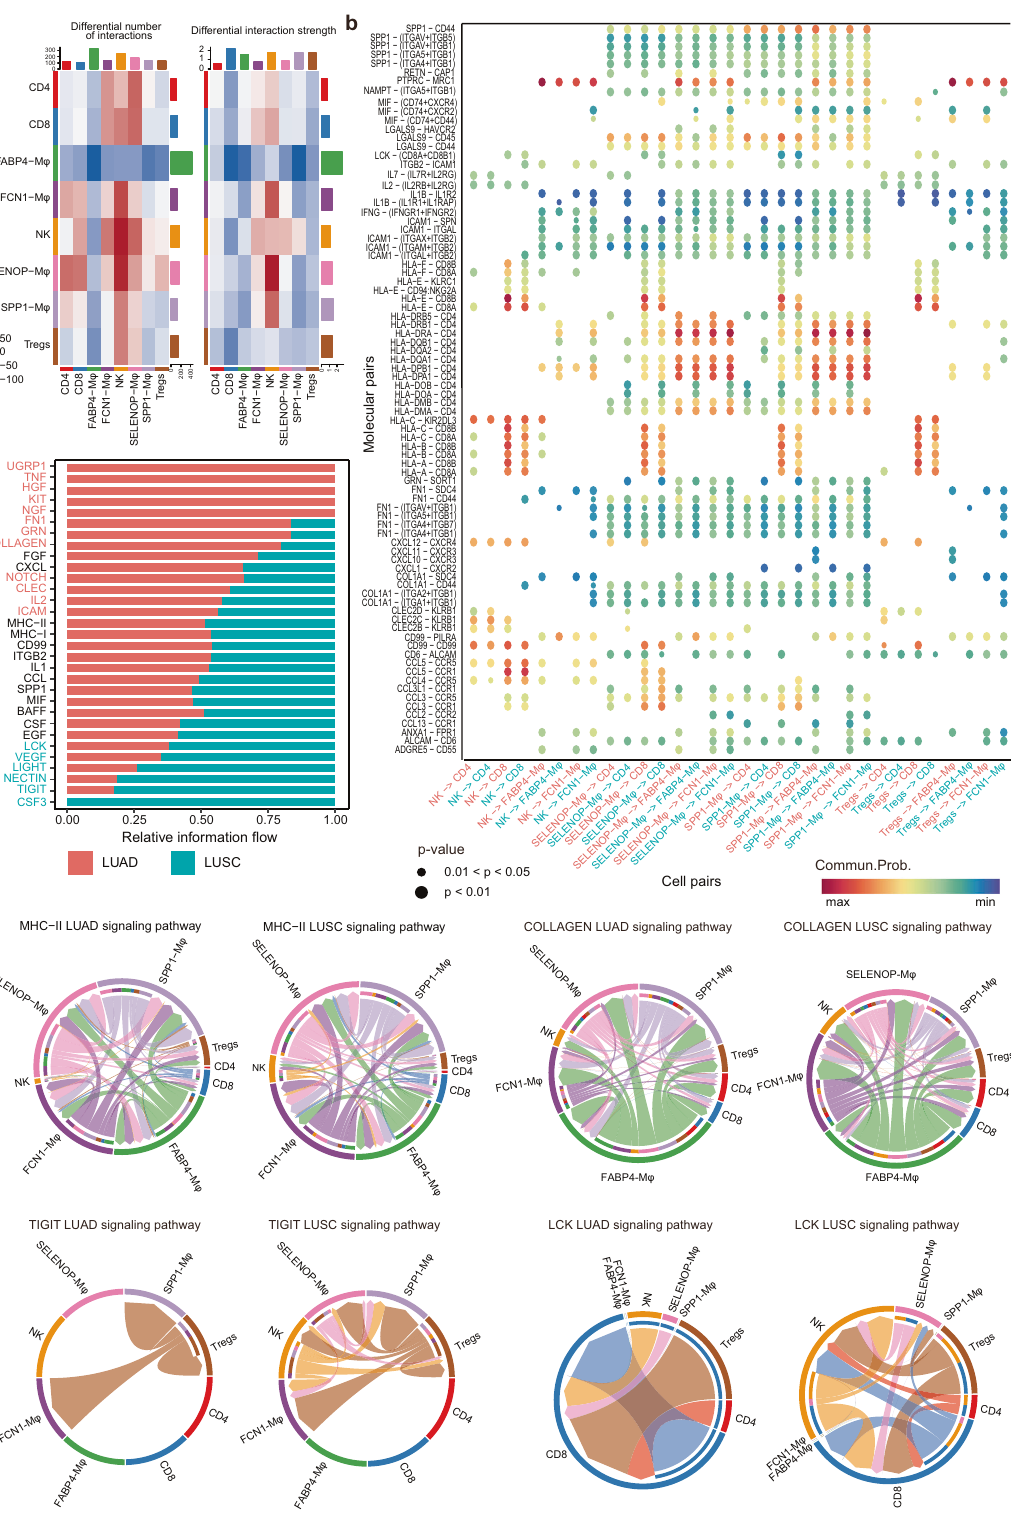
leukocyte antigen genes of HLA-A/B/C/E were more closely interacted with the cytotoxic T lymphocyte (CTL) signature CD8B of these cell pairs in LUAD, but with CD8A in LUSC (Fig. 7b). Then, we predicted the differential signaling pathways and projected them onto a two-dimensional manifold according to